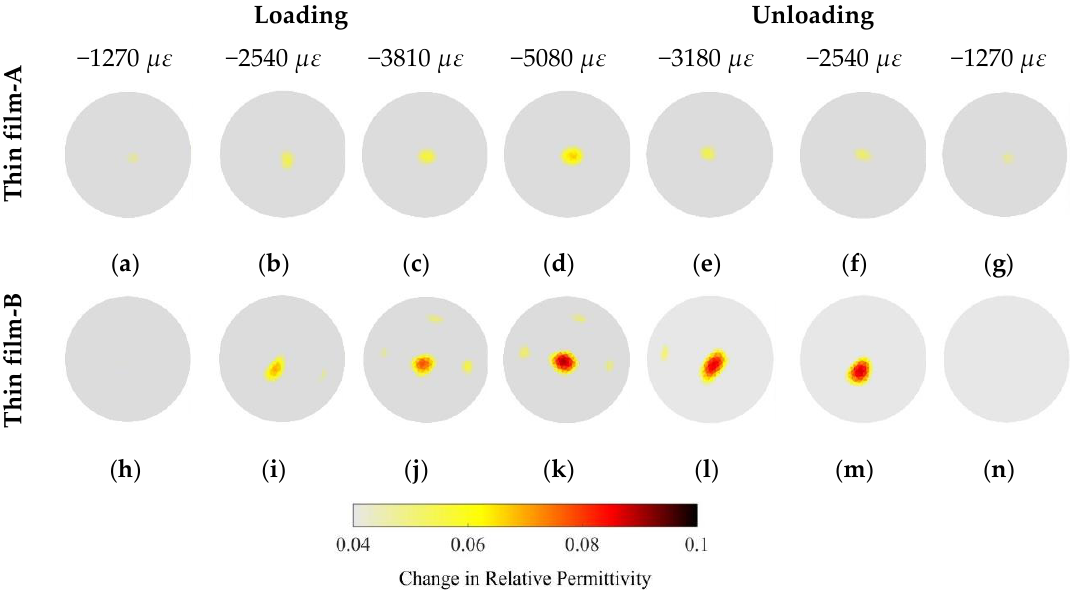
Figure 12. ( a – d ) show the changes in electrical permittivity of the Thin film-A-coated test specimen subjected to uniaxial compressive strain, while ( e – g ) describe the change in electrical permittivity during unloading. The Thin film-B-coated specimen was also subjected to the same loading conditions, and its changes in permittivity are shown during loading (i.e., ( h – k )) and unloading (i.e., ( l – n